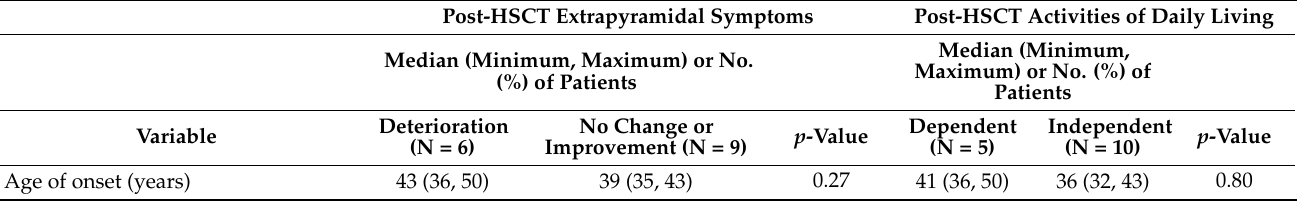
Table 5. Associations of patient characteristics with post-HSCT cognition and neuropsychiatric